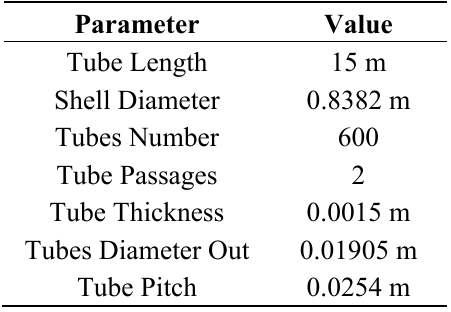
Table 8. Geometrical features of geothermal